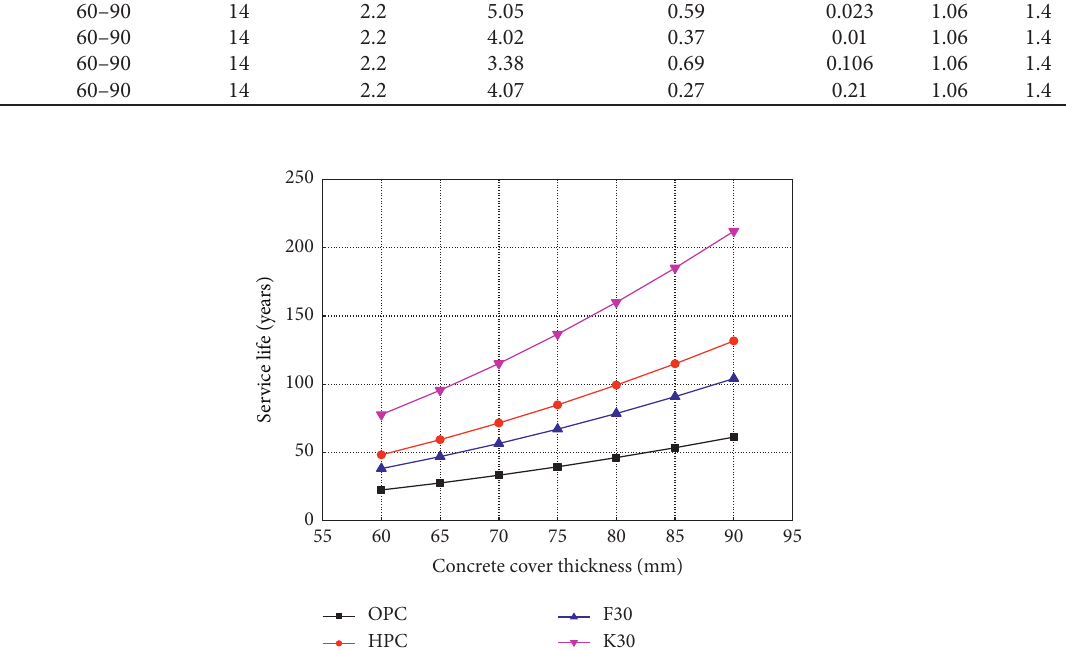
Figure 18: Prediction results with various concrete cover thickness.